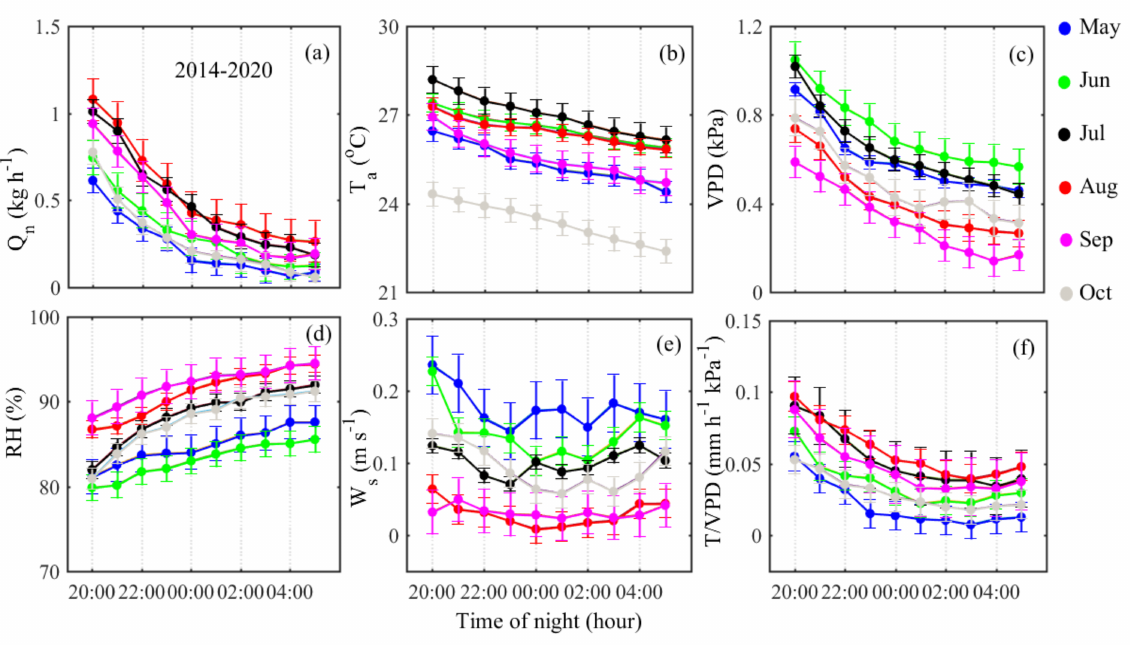
Figure 2. The nocturnal patterns of hourly means of ( a ) sap flow rate (Q n ) and micro- hydrometeorological parameters, including ( b ) air temperature (T a ), ( c ) vapor pressure deficit (VPD), ( d ) relative humidity (RH), ( e ) wind speed (W s ), and ( f ) canopy conductance (as indicated by T/VPD) over the growing seasons of 2014–2020. At a specific time (i.e., 20:00–05:00), each data point shows the mean value for each month, and bars represent the standard error across the 2014–2020 observa- tion